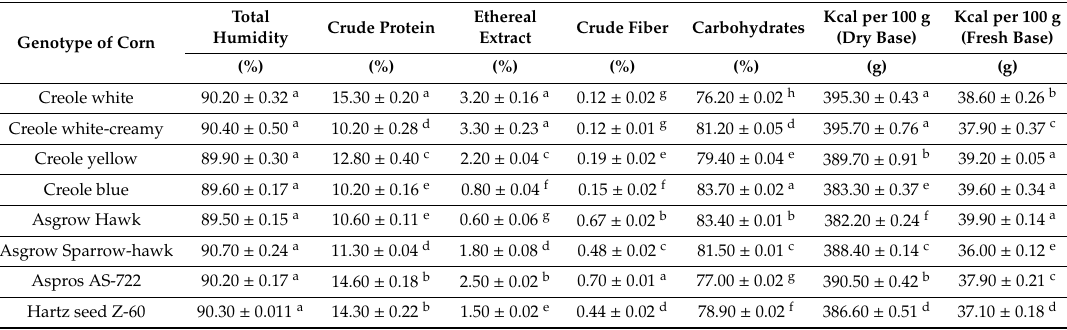
Table 4. Bromatological analysis of the galls obtained for the di ff erent genotypes of corn in Nopalucan, Puebla,